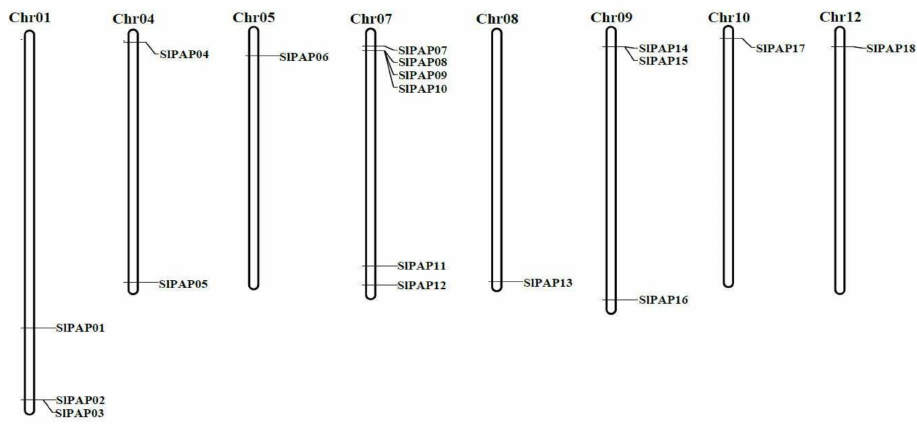
Figure 2. Phylogenetic analysis, intron/exon configurations and conservation motifs of PAP genes in tomato. A phylogenetic tree of PAP genes was constructed using MEGA 5.0. Introns and exons are drawn to scale with the full encoding regions of their respective genes. Boxes indicate the exon, and lines indicate the intron. 0 = intron phrase 0; 1 = intron phrase 1; 2 = intron phrase 2.